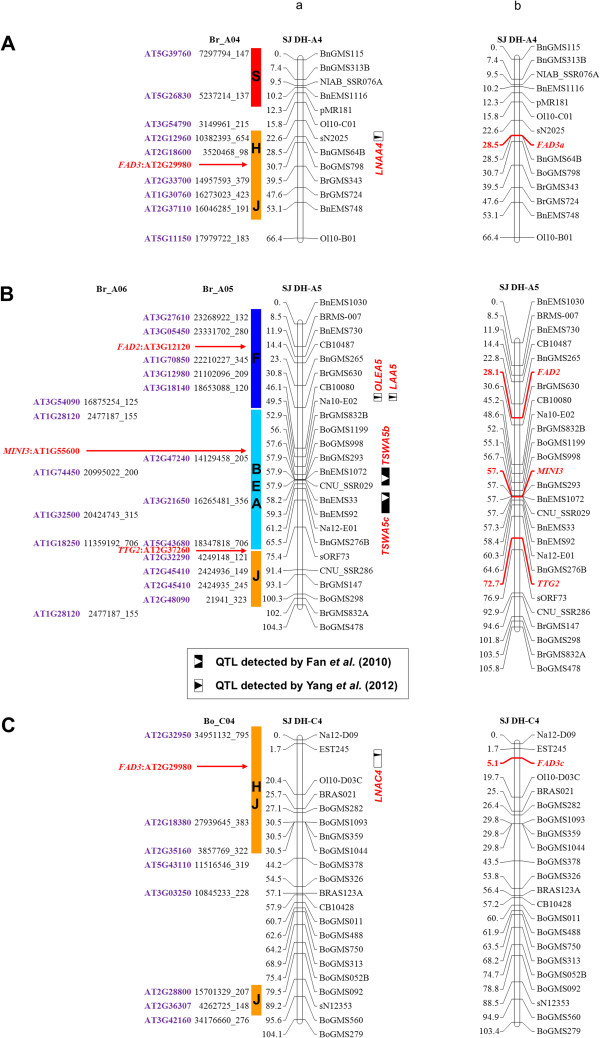
Candidate genes underlying the QTLs identified through comparative mapping. Candidate genes for mapped QTLs on LGs A4 (A), A5 (B) and C4 (C) are predicted with conserved Arabidopsis blocks mapped on B. napus map. Column a illustrates the prediction of the candidate genes. Previously mapped QTLs [11,47] are indicated on the right-hand side of the respective LG and the conserved Arabidopsis blocks (color bars with their names (letters) inside) on the left. The homologous loci in B. rapa/B. oleracea and Arabidopsis are listed next to the conserved blocks. Red arrows indicate the positions of the predicted candidate genes. Column b presents LGs A4 (A), A5 (B) and C4 (C) with newly added gene-specific markers.